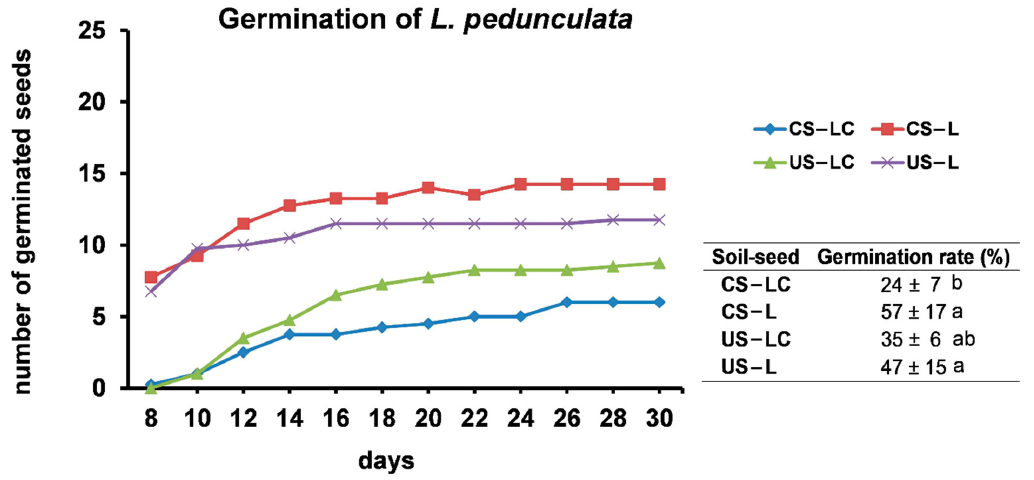
Figure 1. Germination of L. pedunculata seeds from S ã o Domingos (LC) and Caldeir ã o (L) growing in the contaminated soil from S ã o Domingos (CS) and the uncontaminated soil from Caldeir ã o (US) over time (30 days). Inset table shows the values of the germination rate after 30 days (average ± standard error, n seeds = 25; n pots = 4). Different letters indicate significant differences among soil/plant treatments for germination rates at 30 days ( p <